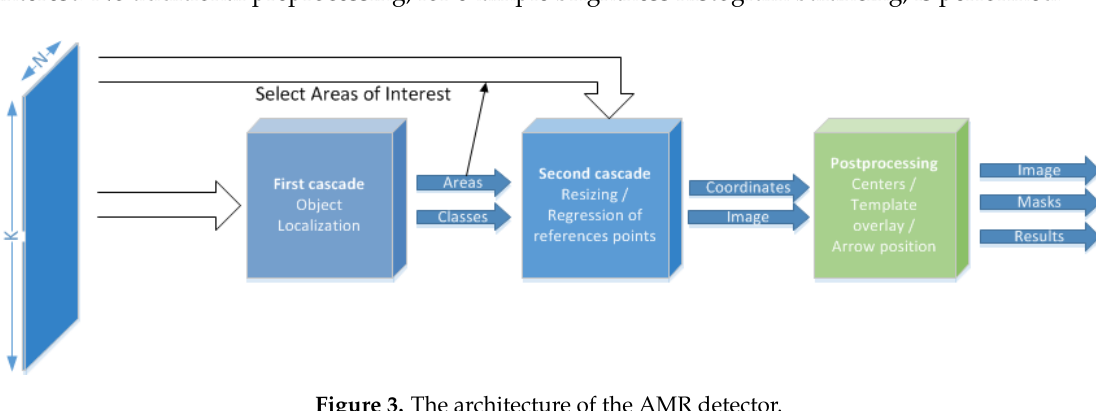
Figure 3. The architecture of the AMR detector.